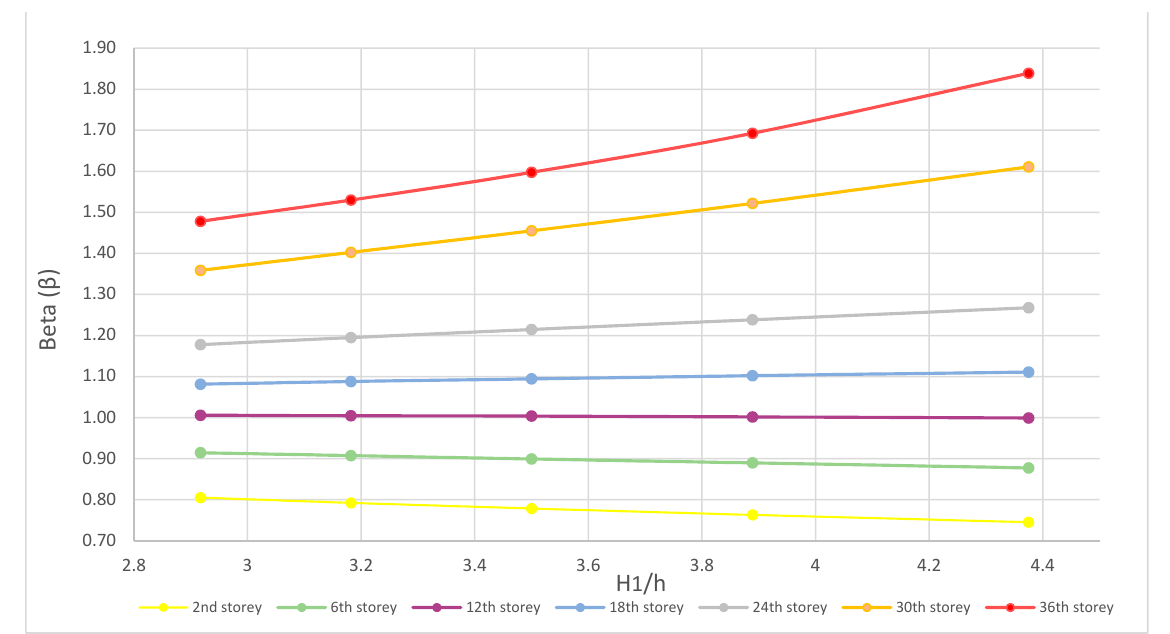
Figure 10. The change in the shear lag effect with the variation of beam height ( β —H 1 /h diagram).